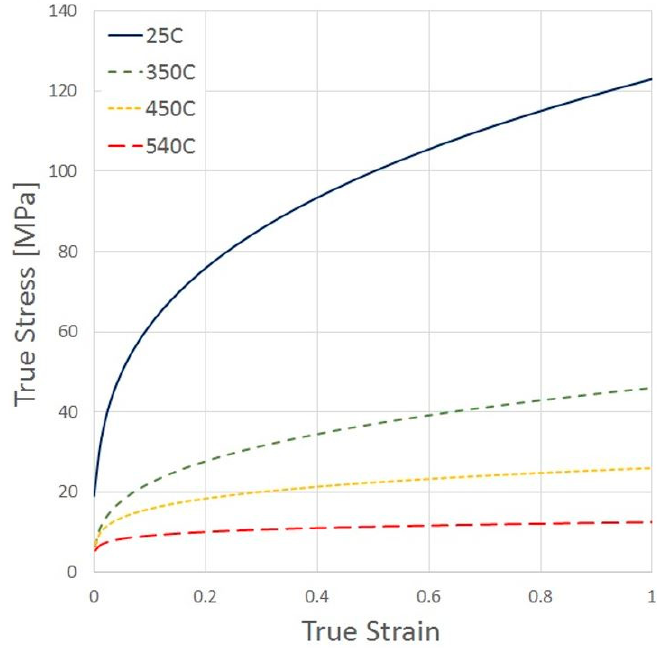
Figure 7. Flow stress curves for Al1050 using the converged FE model at different temperatures.